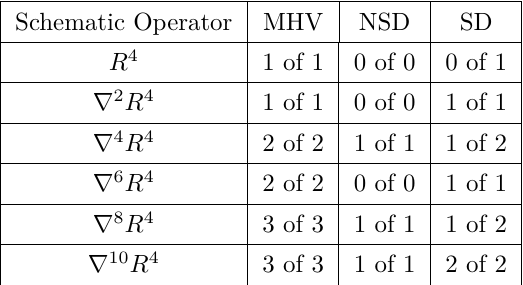
Table 3 . Number of independent local operators out of the total possible contributing to the 4- graviton amplitude: we list how many operators are generated by any version of the KLT double copy (generalized / field theory BAS / string